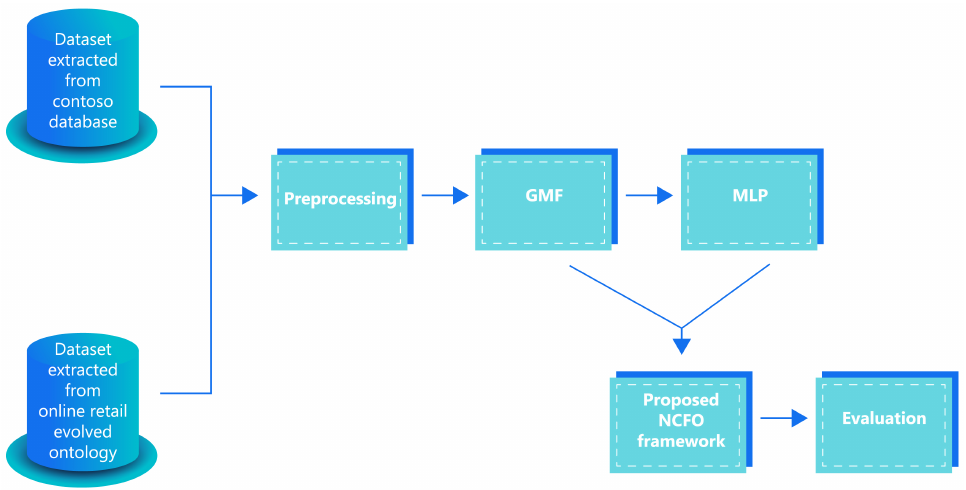
Figure 2. NCFO framework: the original and evolved databases are preprocessed first to encode the features. These are later input to a generalized matrix factorization and a neural collaborative filter to obtain the recommendations. The evaluation block measures the performance of the whole